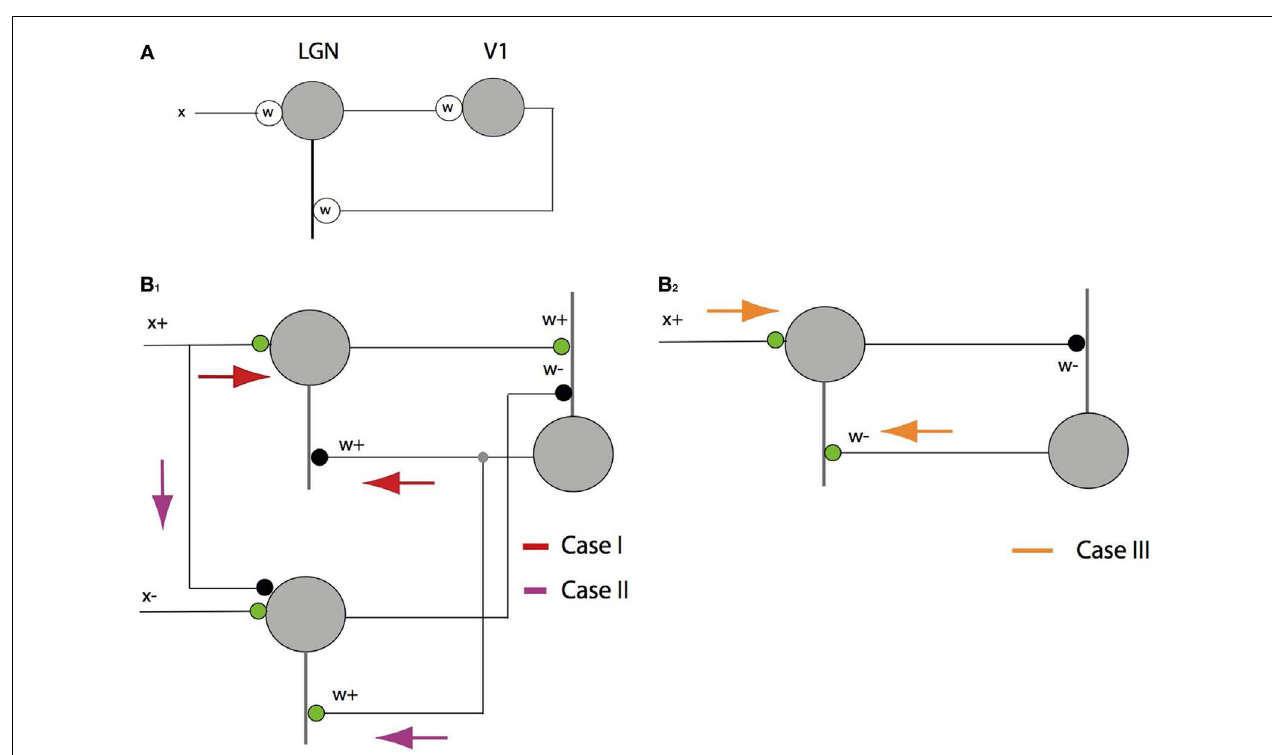
the simplest to understand case x + > β w + > 0, the feed forward circuit computes the projection β and the feedback component is inhibitory. Case II: when x + < β w + , things are more complicated as the feedback must excite the complementary LGN cell. (B 2 ) Case III: when w − > 0 the feedback is excitatory also but to the x + cell.